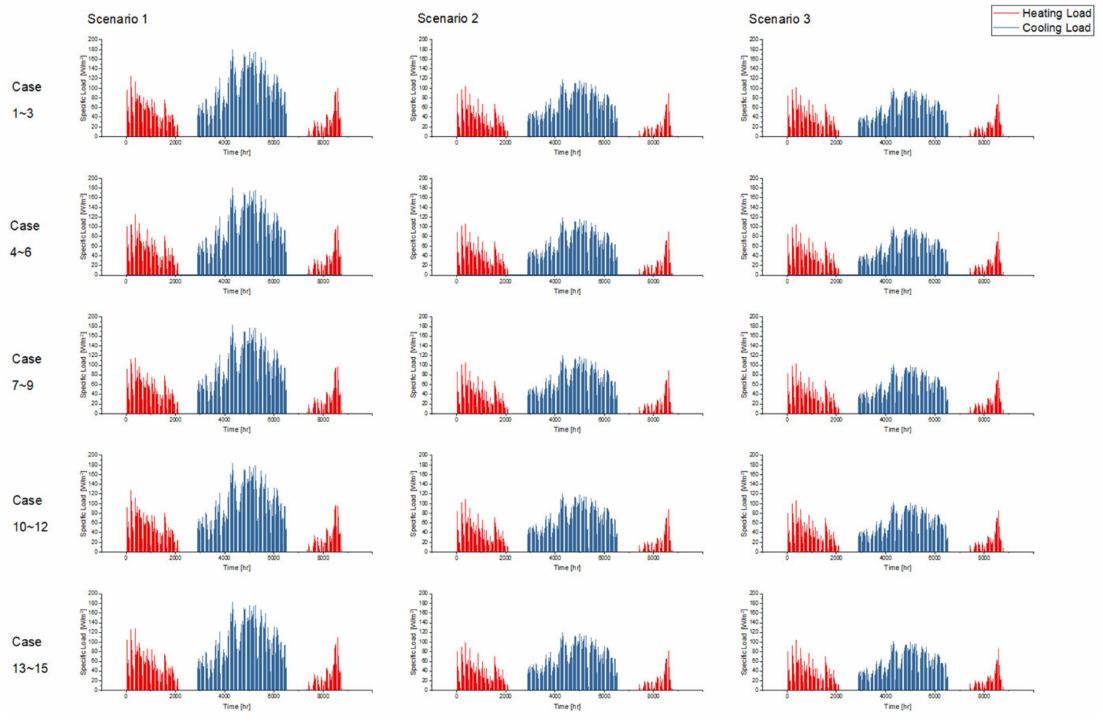
Figure 13. Original results of Cases 1~15.